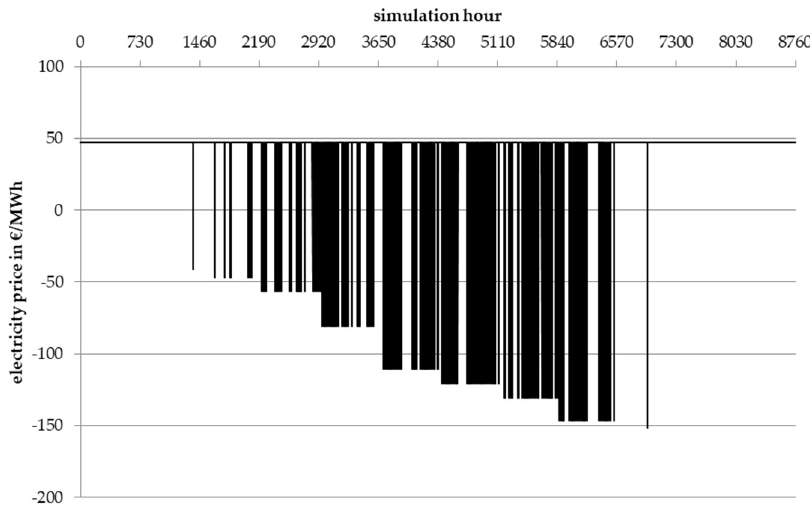
Figure 1. Market prices for one year in the simple scenario.